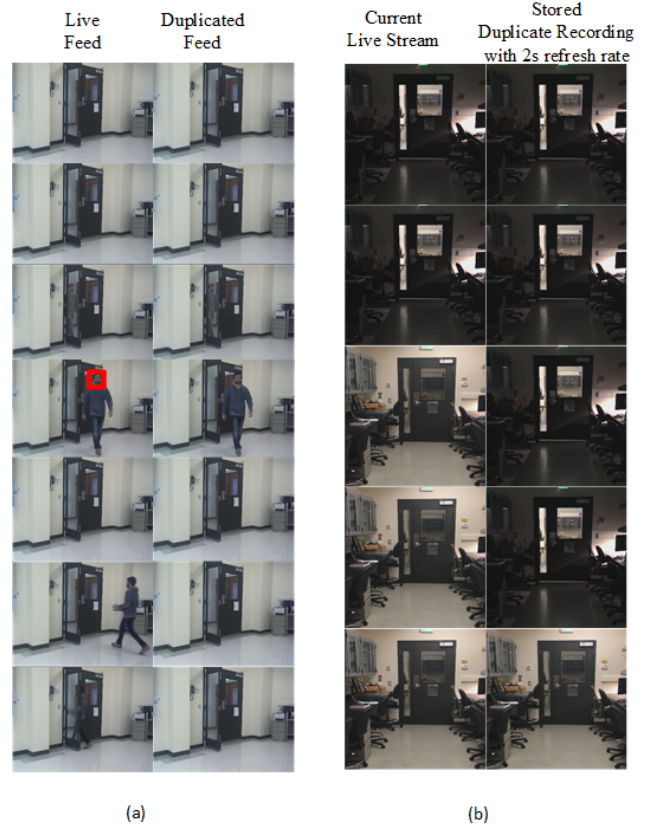
Figure 6. Frames of live and duplicated feed. ( a ) Attack triggered after detecting a face encoding and launched when a static scene appears, and ( b ) updating the duplicated static scene recording based on changes in light intensity of the